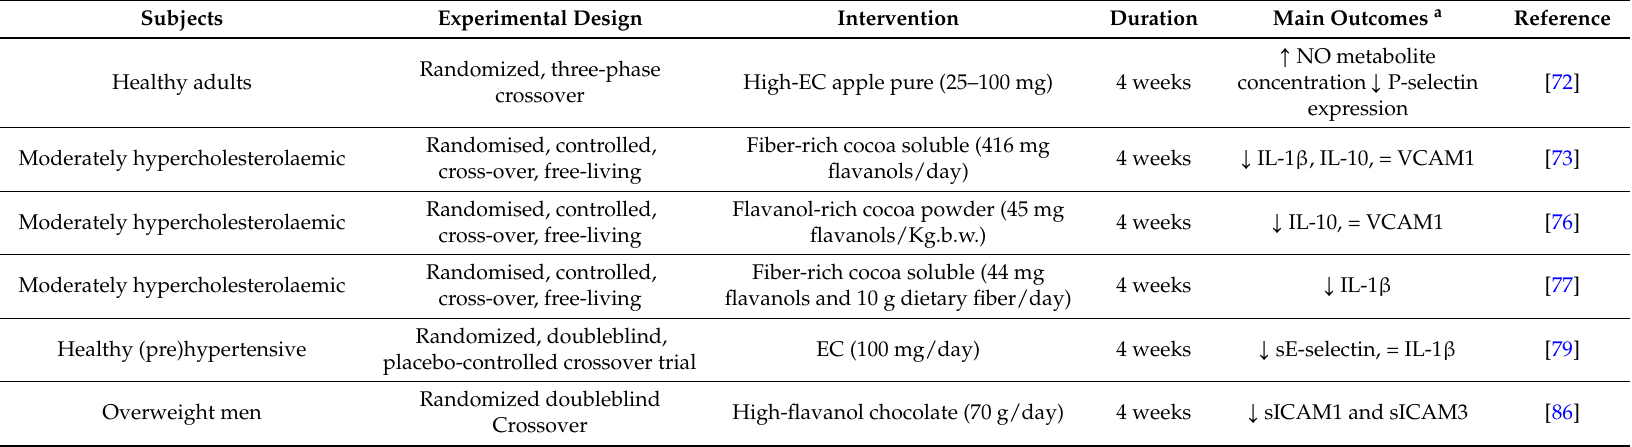
Table 4. Summary of most recent effects of cocoa and cocoa flavanols on anti-inflammatory markers in human